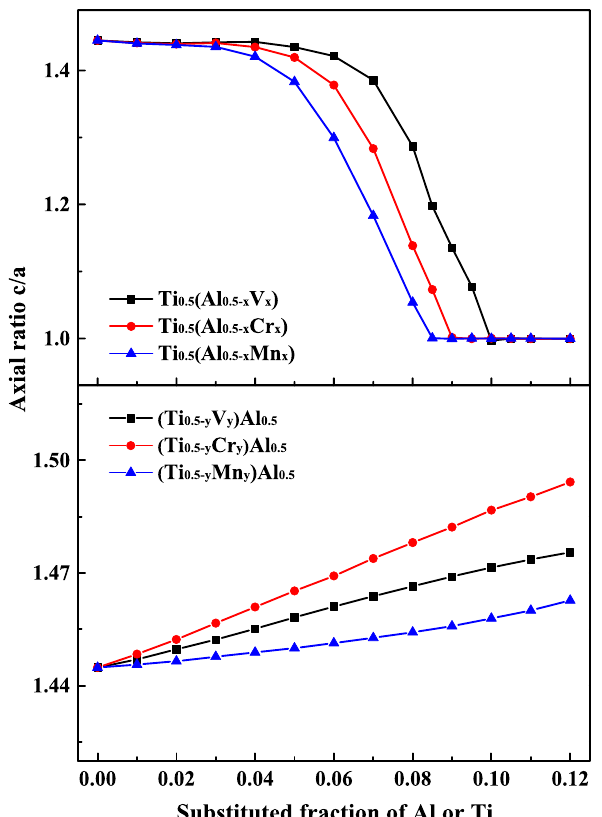
Figure 2. Axial ratios (c/a) as a function of composition, Ti 0.5 (Al 0.5−x X x ) (X = V, Cr, and Mn; x = 0–0.12) (top), (Ti 0.5-y X y )Al 0.5 (X = V, Cr, and Mn; y = 0–0.12)